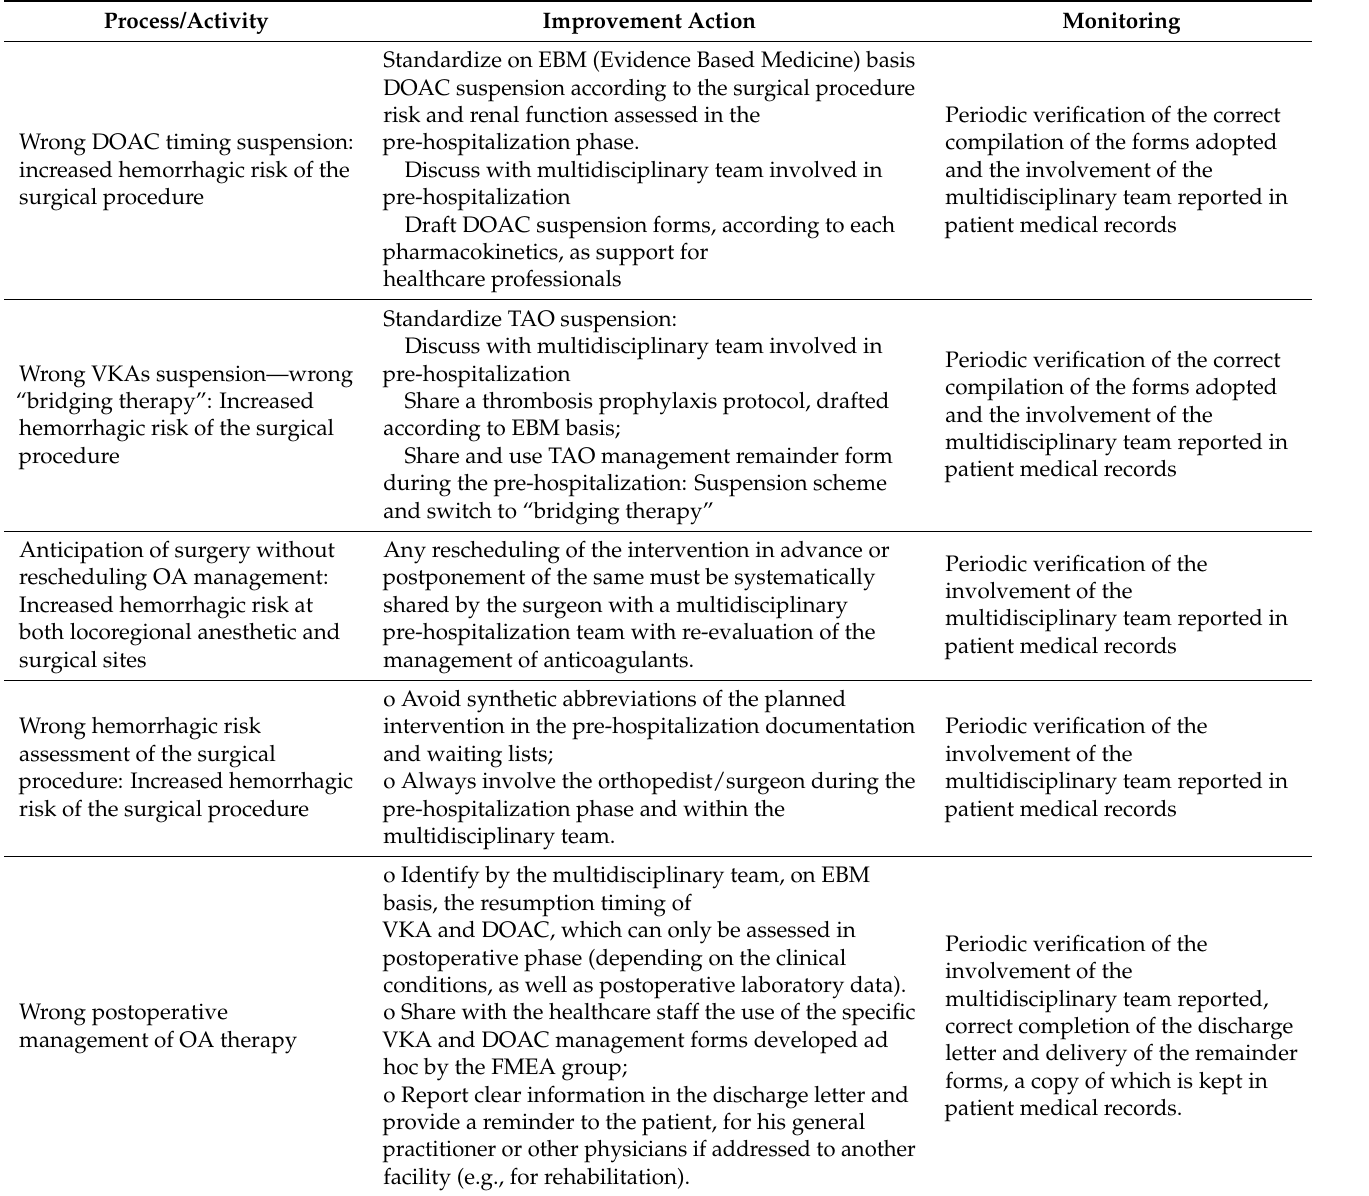
Table 4. Proposed improvement plan to face failure modes with a higher level of concern and priority from FMEA working